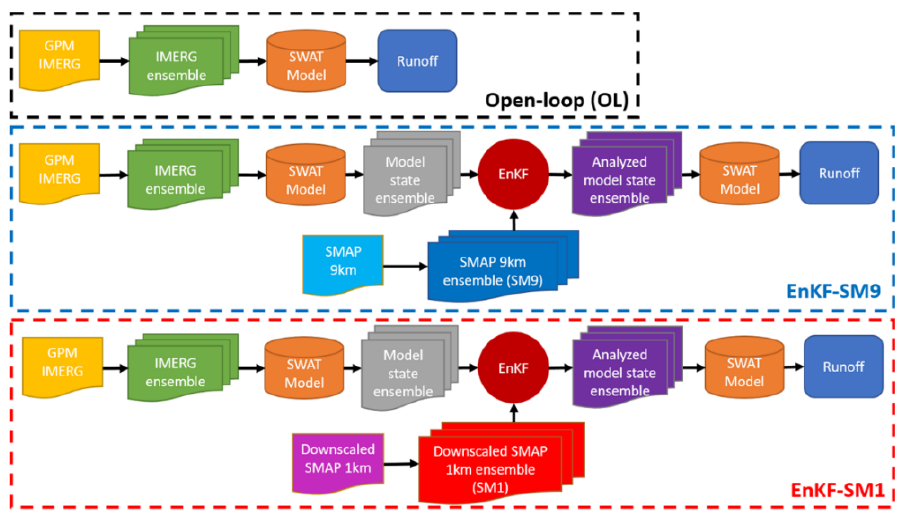
Figure 2. Flow chart of this study. EnKF-SM9 and EnKF-SM1 stand for streamflow simulations using the SWAT model with the state variable of SM9 and EnKF technique, and streamflow simulations using the SWAT model with the state variable of downscaled SM1 and EnKF technique, respectively.